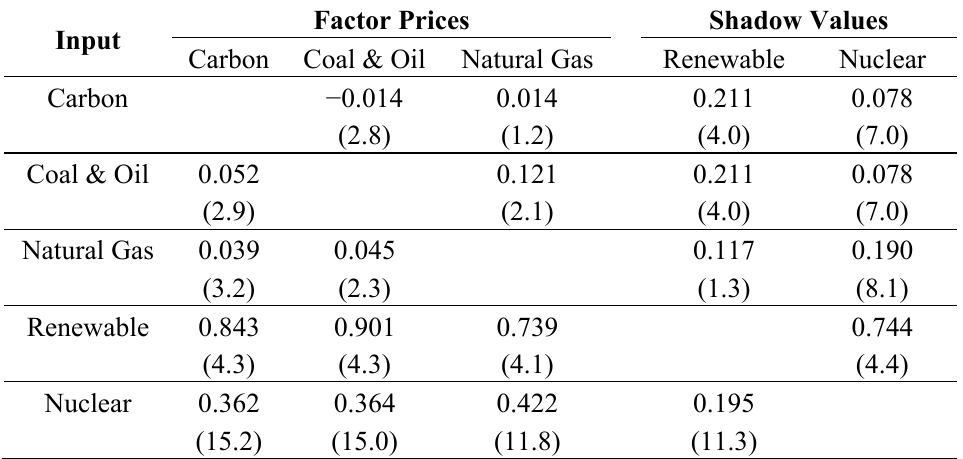
Table 6. Morishima elasticities of substitution (asymptotic t -ratios in